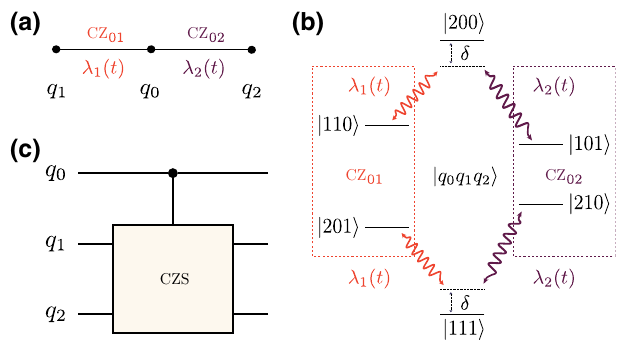
FIG. 1. Setup and operation for the three-qubit gate realized through simultaneous application of two CZ gates. (a) The setup considered is a linear chain of three qubits with nearest-neighbor coupling. Going from left to right in the chain, we denote the qubits q 1 , q 0 , and q 2 . The CZ gates CZ 0 j between qubits 0 and j = { 1, 2 } are applied simultaneously by activating a coupling between the | 1 0 1 j (cid:2) and | 2 0 0 j (cid:2) states with the coupling strength ( t ) . (b) The transitions in the three-qubit system activated λ j by the application of the CZ gates. With the three-qubit states denoted by | q 0 q 1 q 2 (cid:2) , the transitions | 11 x (cid:2) ↔ | 20 x (cid:2) with x = | 1 x 1 (cid:2) ↔ { 0, 1 } are activated by CZ 01 (red), and the transitions | 2 x 0 (cid:2) are activated by CZ 02 (purple). We assume that both CZ gate operations are detuned by δ from resonance. (c) We denote the three-qubit operation resulting from the simultaneous application of the two CZ gates by CCZS (controlled- CZS ), since it applies both CZ and SWAP gates to the target qubits q 1 and q 2 conditioned on the control qubit q 0